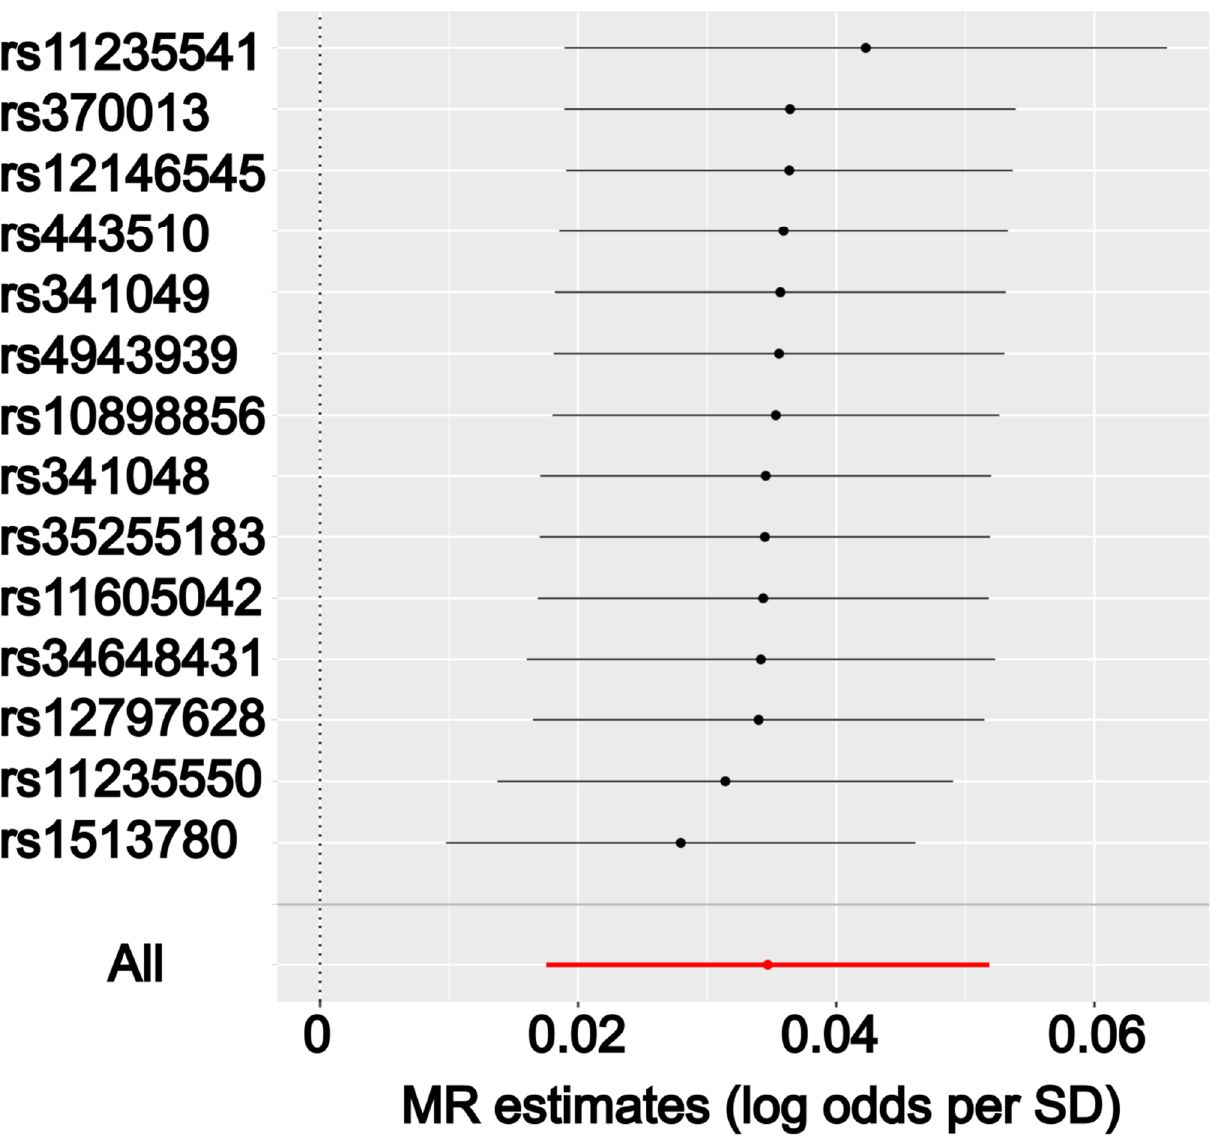
Figure 4. Results from leave-one-out sensitivity analysis. The y-axis shows the ID of the SNP to be excluded from analysis and the x-axis shows the MR estimates (odds ratios). The red line indicates the MR estimate using all SNPs. Hsa-miR-139-5p putatively leads to increased odds of hospitalization. Only one representative relationship was shown here. Complete results are available from the Supplementary Figures.